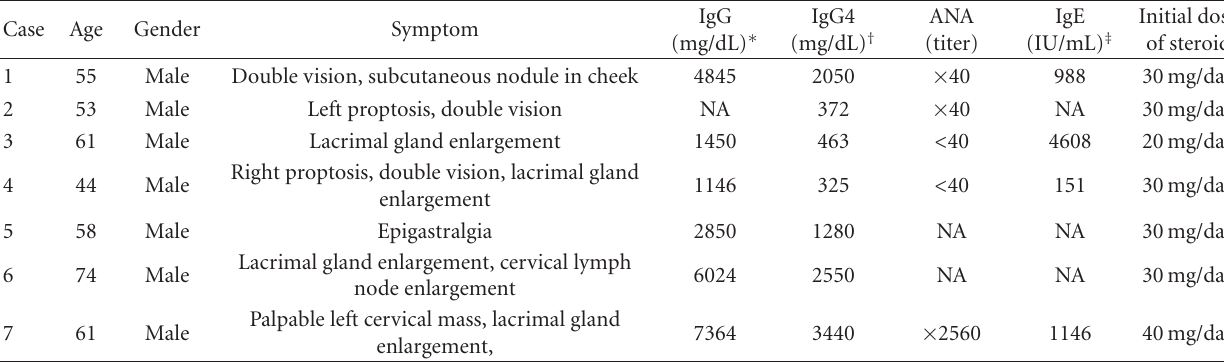
Table 1: Clinical characteristics, laboratory data, and initial dose of steroid.